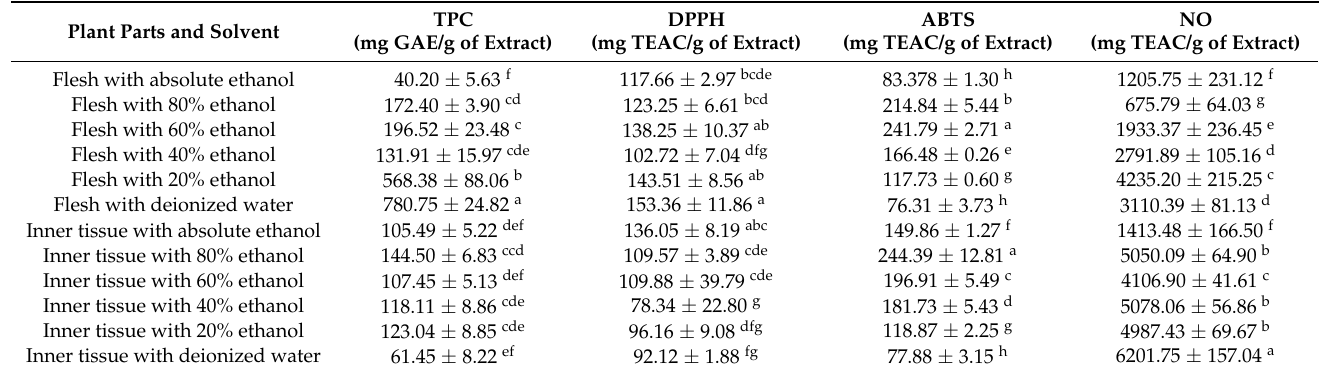
Table 3. The total phenolic content (TPC), ABTS, DPPH, and nitric oxide radical scavenging activities of M. charantia